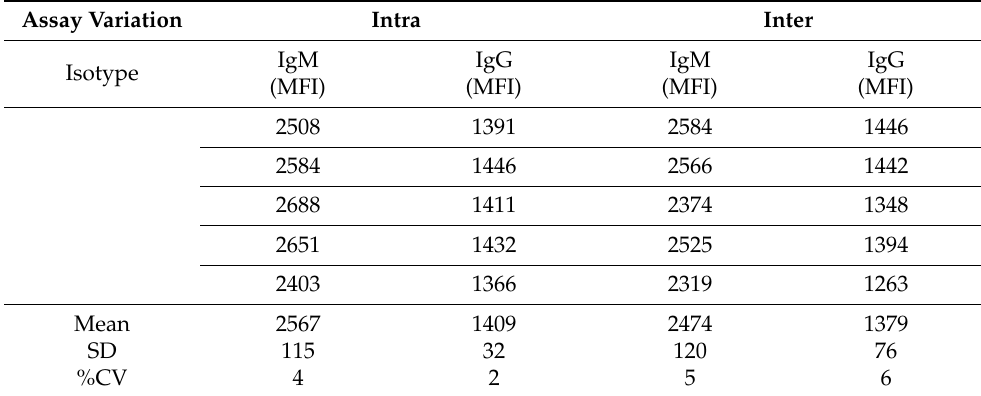
Table 2. Assay variability of the COVID-19 SIA.